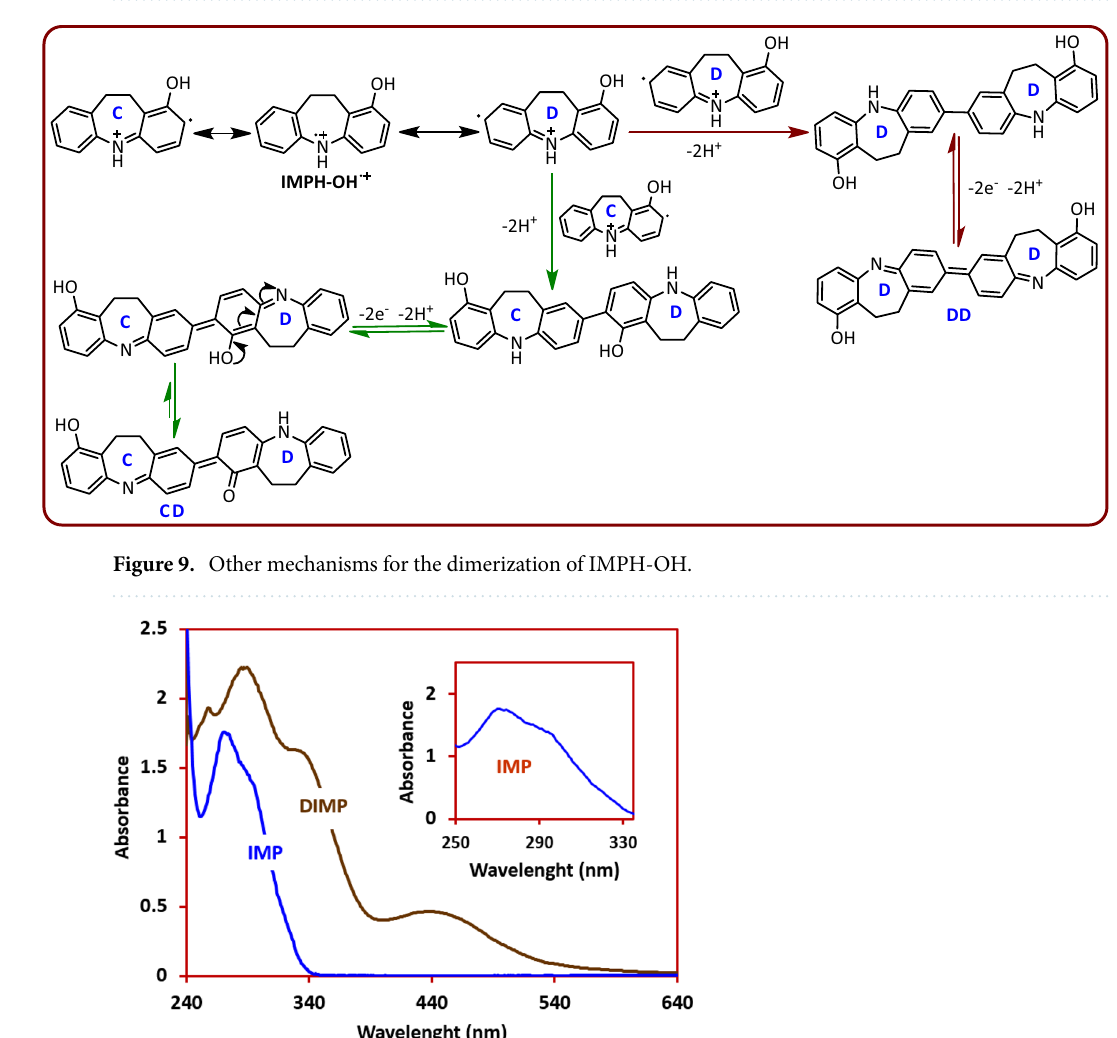
Figure 8. Possible structures due to the increase of water to different positions of the IMPH •+ molecule.